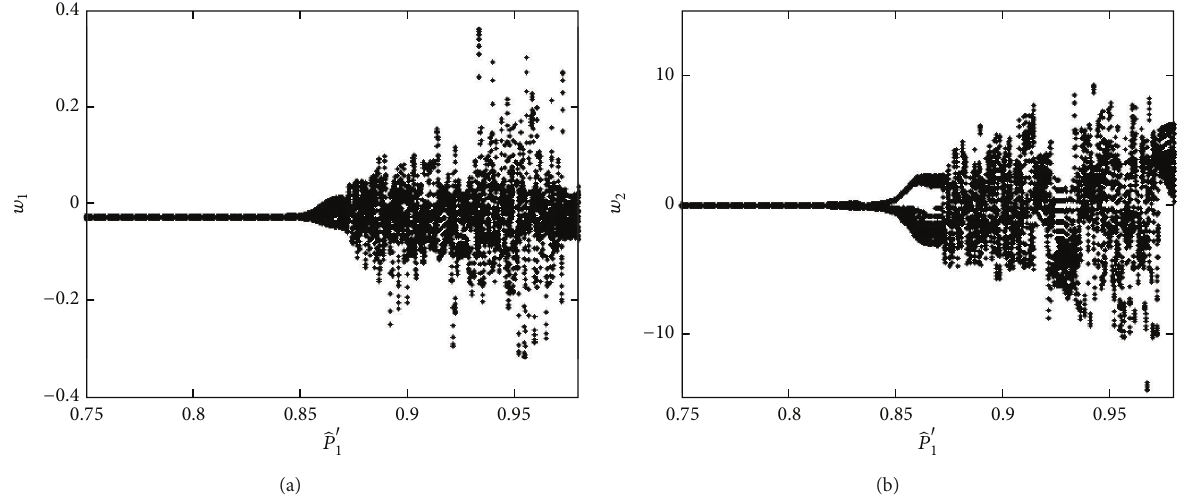
Figure 7: (a) and (b) depict the bifurcation diagrams of 𝑃 󸀠 1 versus 𝑤 1 and 𝑤 2 which are given when the Mach number is taken to be 10.0. The value of horizontal coordinate has the same definition as that in Figure